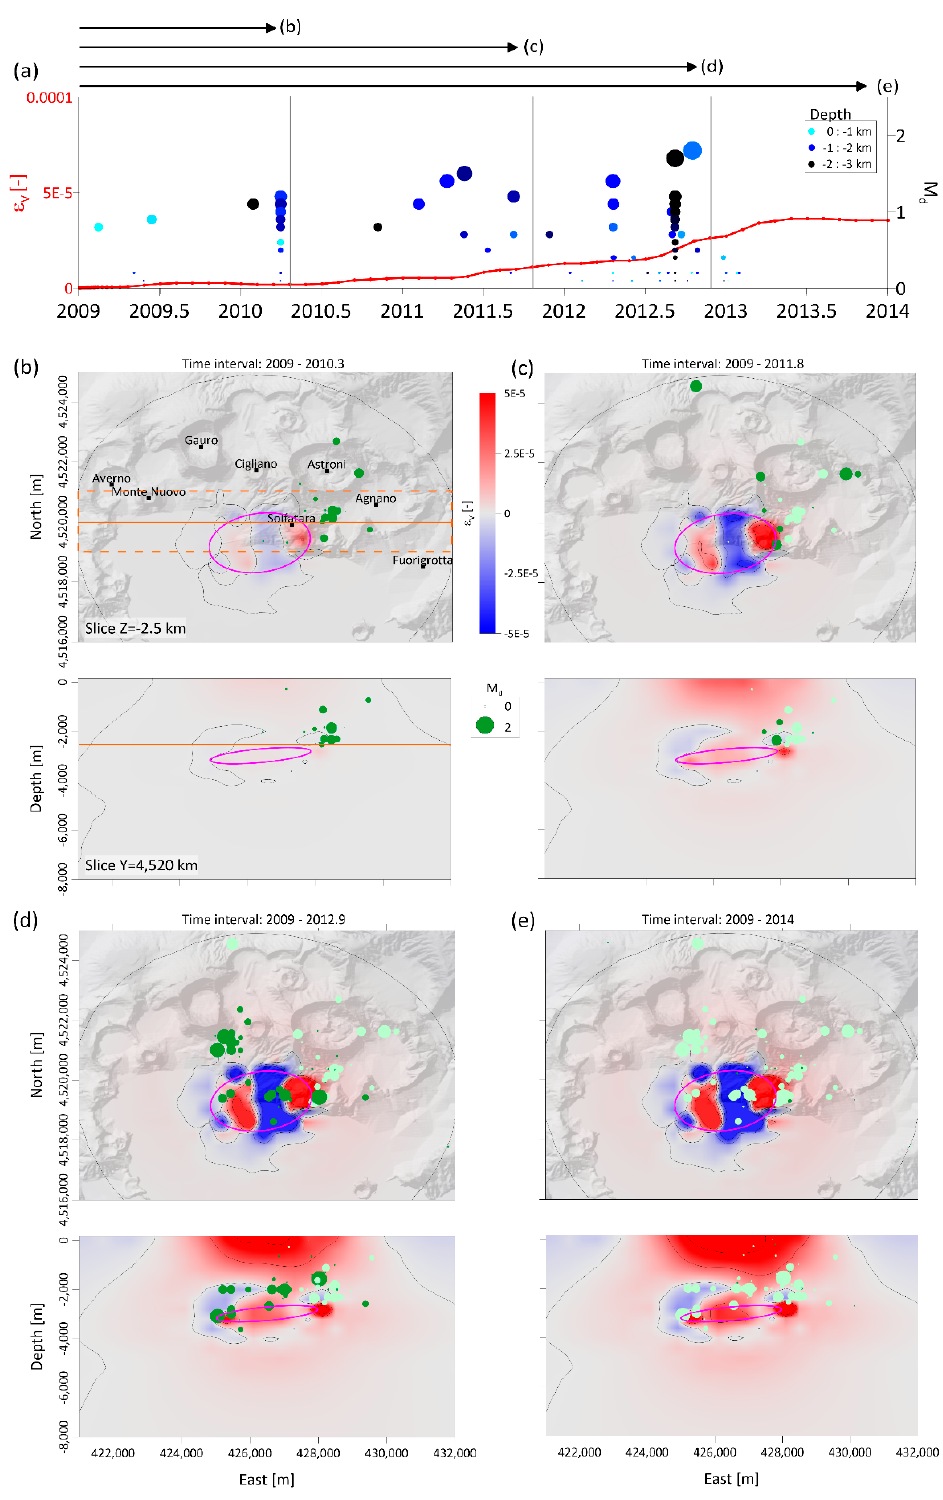
Figure 11. Volumetric strain field analysis. ( a ) The 2009–2013 time series of modeled strain at point (E = 426 km; N = 4520 km; Z = –2.5 km); the CF caldera seismicity history, represented by circles with different color (depth) and size (magnitude), is superimposed. ( b – e ) Volumetric strain field evolution and earthquake distribution with M > 0 related to four periods: ( b ) 2009–2010.3; ( c ) 2009–2011.8; ( d ) 2009–2012.9; ( e ) 2009–2014. The dark green circles indicate the successive earthquakes with respect to the previous ones (light green). The orange lines represent the location of the vertical and horizontal sections. In these cross-sections, only the seismic events that fall within the dashed rectangle (buffer ± 1 km) in panel ( b ) are